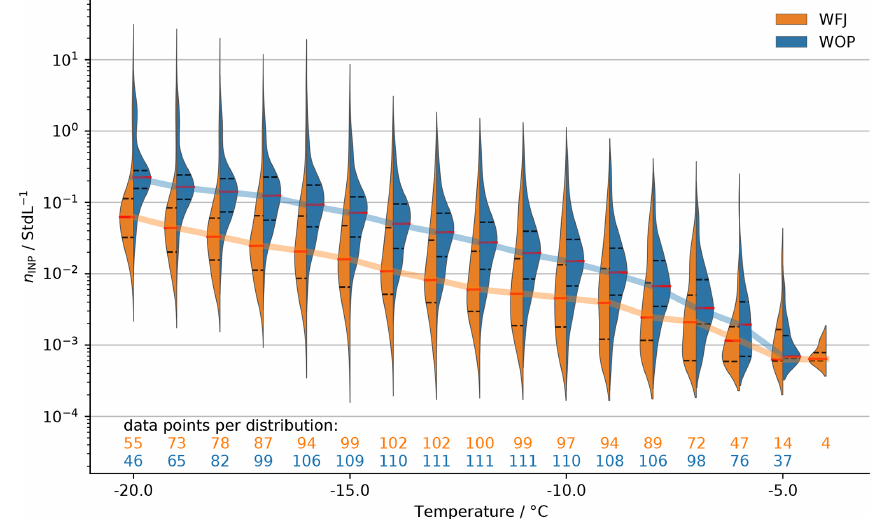
Figure 3. Cumulative INP concentration ( n INP ) violin plots per temperature of all collected samples at WFJ (orange) and WOP (blue). For each distribution, the median is given in solid red lines, and the 25th and 75th percentiles are shown in dashed black lines. The lines connect the distribution medians. At the bottom of the figure, the number of data points at each temperature is shown in orange and blue for WFJ and WOP,